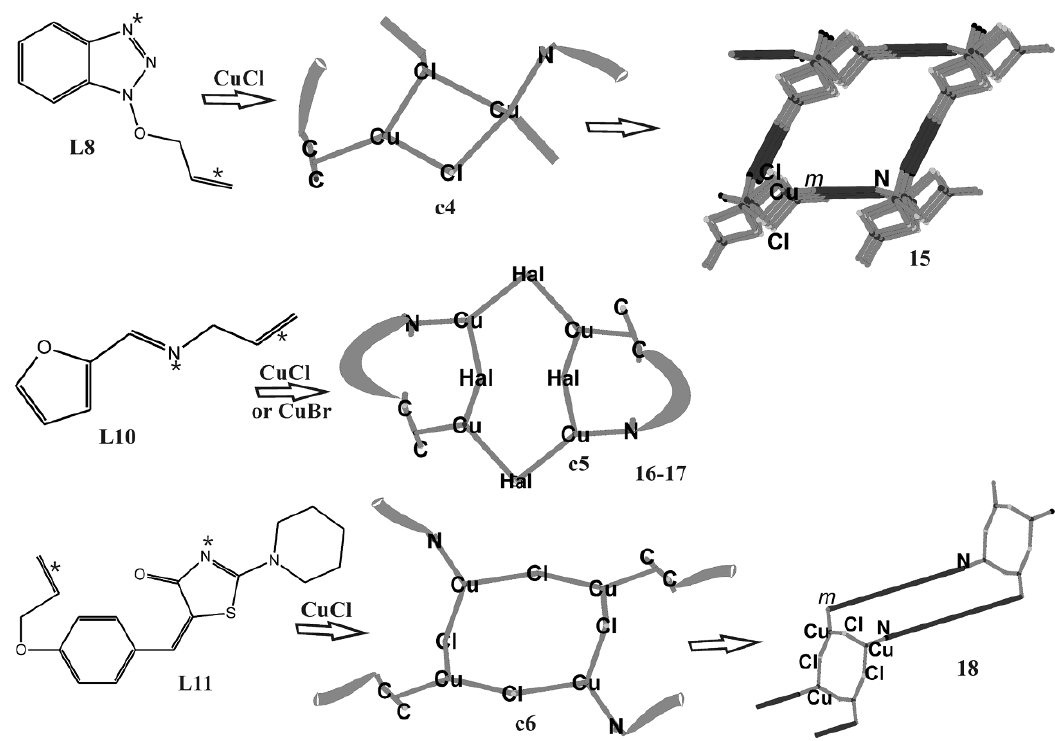
Figure 4. Structural genesis of C5 and C6 fragments in 15-18